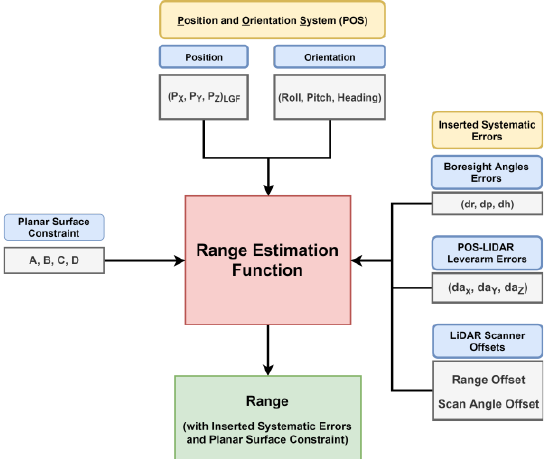
Figure 5 – Flowchart of the range estimation function